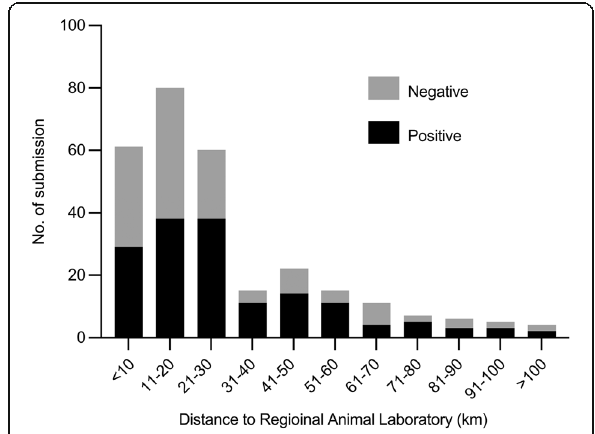
Fig. 4 Distribution of sample submissions by